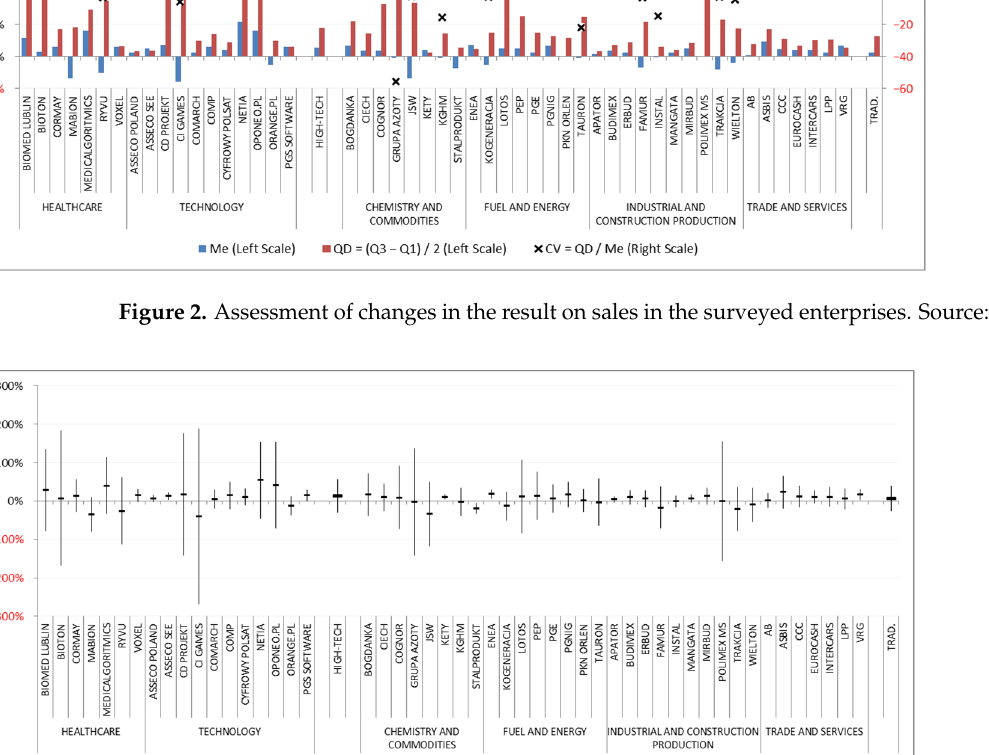
Figure 3. A typical area of variation of the result on sales in the surveyed enterprises. Source: own work.